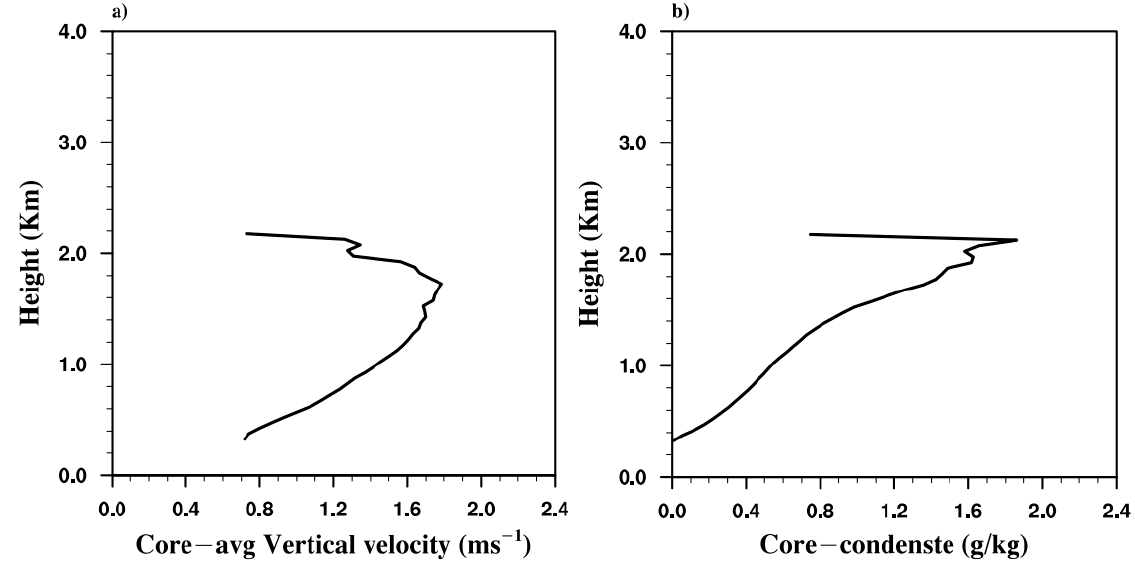
Figure 5. Cloud core profiles of: ( a ) vertical velocity and ( b ) cloud condensate.